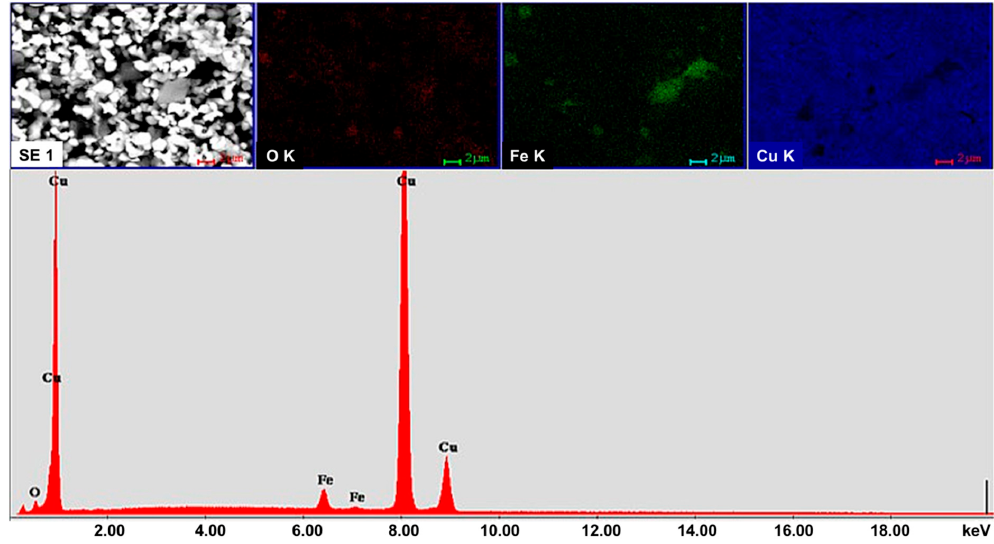
Figure 2. SEM image and the associated elemental mappings of Cu, O and Fe, along with the EDS spectra for a powder mixture of Cu-15%Fe 3 O 4 (line bar is 2 µm).